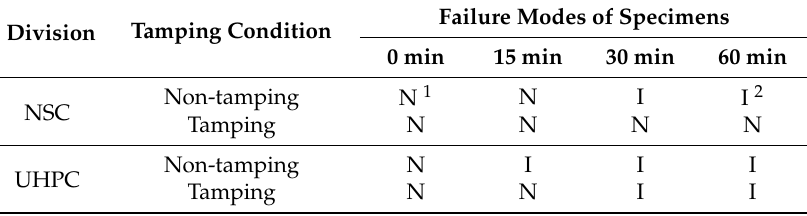
Table 9. Failure modes of specimens.